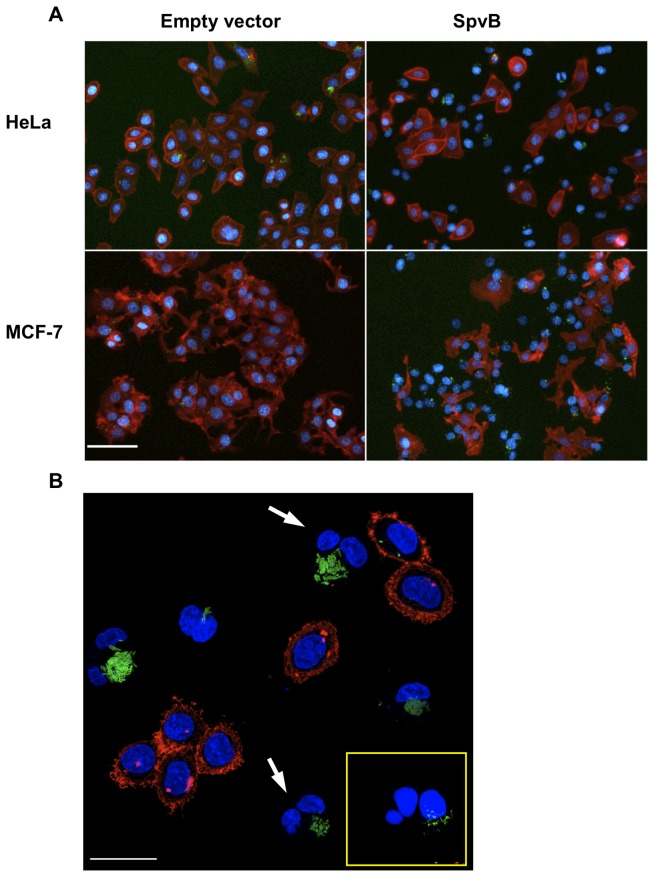
Effect of salicylate-dependent SpvB intracellular overexpression in tumor
cells. (A) Fluorescence microscopy analysis of HeLa or MCF-7 cells infected with Salmonella MPO302 (ΔspvB) bearing the high-copy plasmids pMPO52 (empty vector) or pMPO1036 (SpvB) 4 h post-induction (320x). Scale bar: 50 μm. The MPO302 strain constitutively expresses GFP (green). The cells were simultaneously stained with phalloidin-rhodamine for polymerized actin (red) and Hoechst 33258 to stain eukaryotic and bacterial DNA (blue). (B) Higher magnification of infected HeLa cells culture 20 h post-induction using the Confocal Microscope Leica SPE (630x). Many infected cells show two nuclei (arrows) and some present fragmented nuclei (yellow box inset). Scale bar: 20 μm.